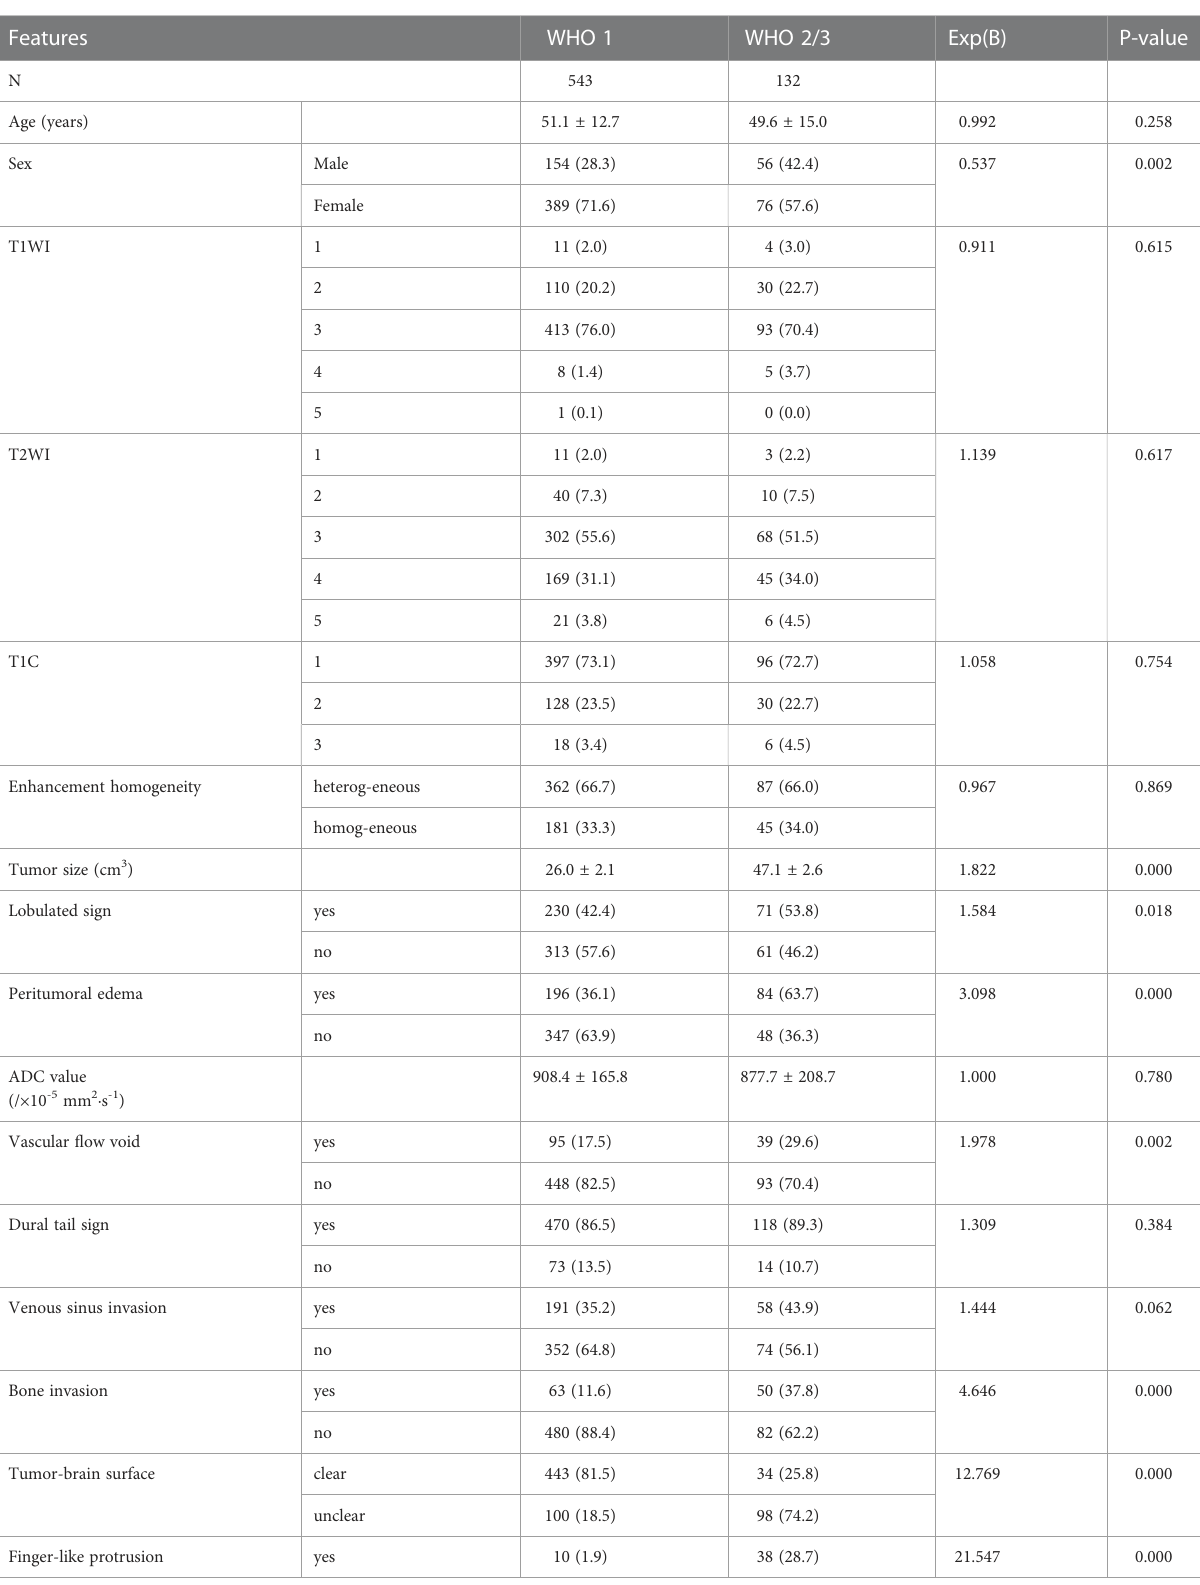
TABLE 2 Univariate analysis of features associated with WHO grades